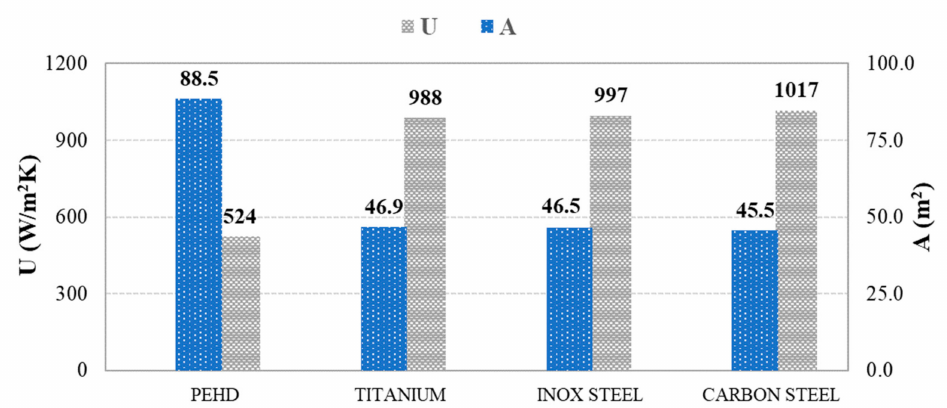
Figure 5. Overall heat transfer coe ffi cient and heat transfer surface area.